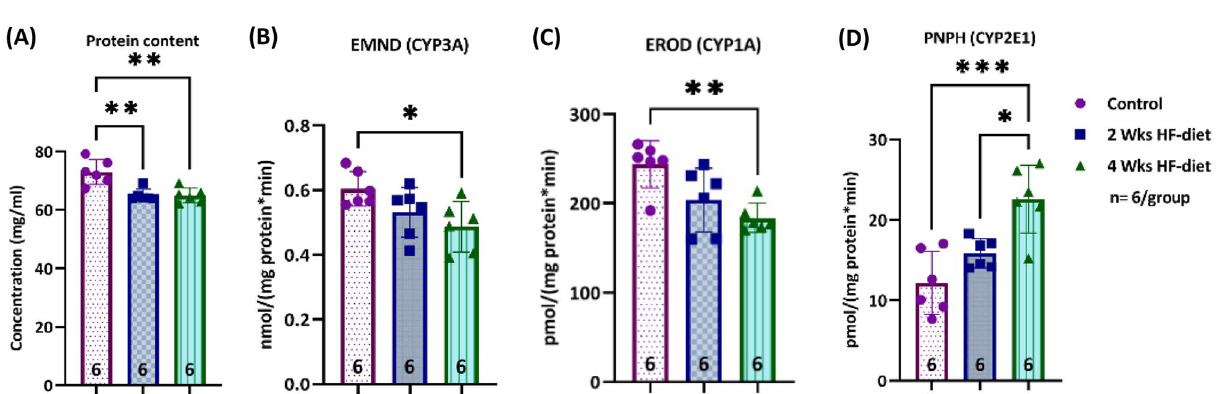
Figure 4. CYP activity. ( A ) Protein concentration in liver samples was statistically significantly lower in steatotic samples compared to control, but similar in the two experimental groups; ( B ) CYP3A activity determined with the EMND assay was significantly lower in the samples from animals with severe steatosis as determined by the lipid droplet analysis; ( C ) The results of the EROD assay for CYP1A activity showed significantly lower activity in the samples from animals with severe steatosis; ( D ) The PNPH assay for CYP1E1 activity showed increasing activity with increasing steatosis severity (*significance level < 0.05, **significance level < 0.01, ***significance level < 0.001, ****significance level < 0.0001, sample size of each group displayed in the bottom of the